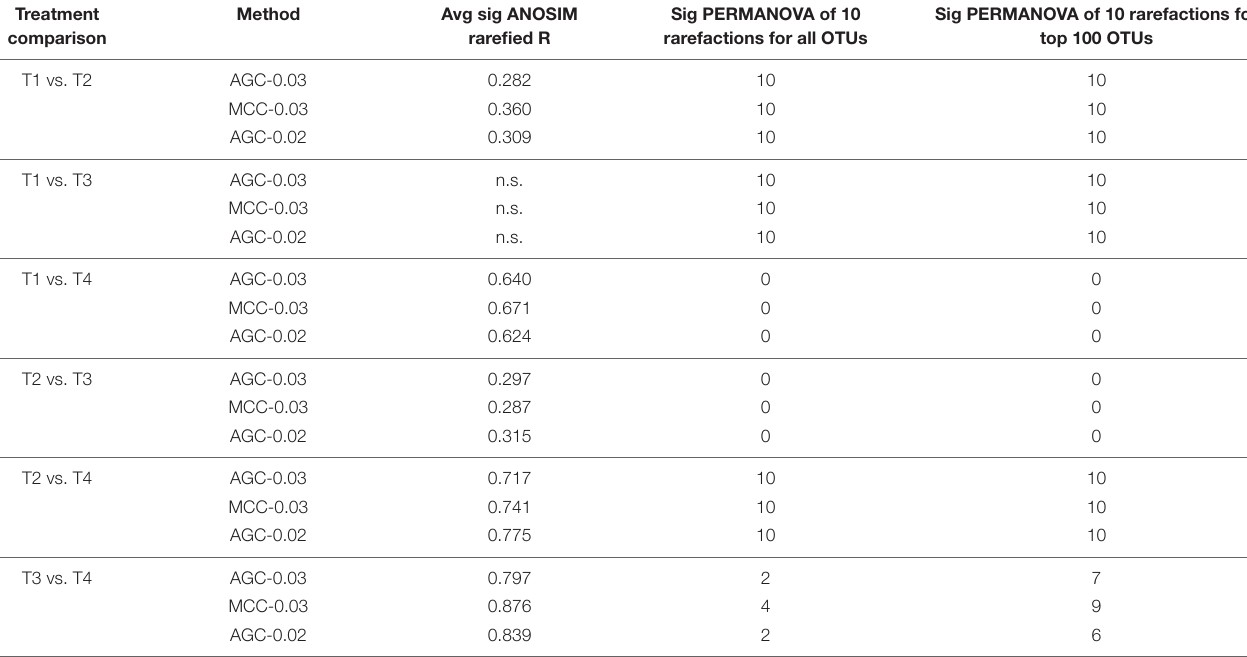
TABLE 3 | nifH community analysis results for each clustering method across ten independent rarefaction trials. Treatment